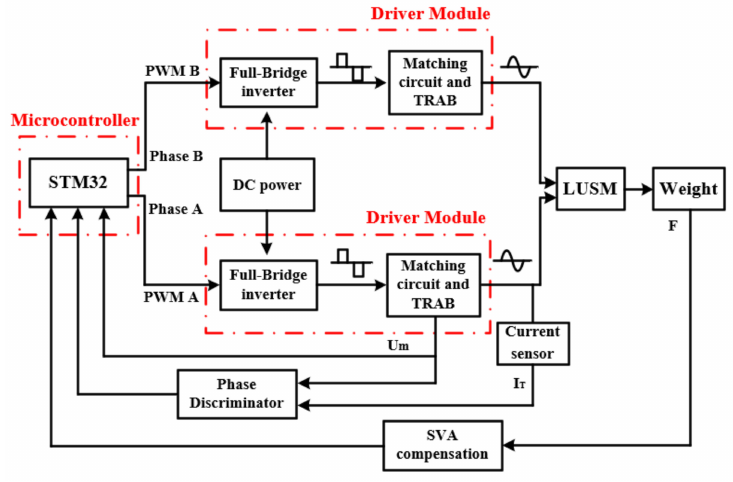
Figure 4. Hardware architecture of the proposed scheme.